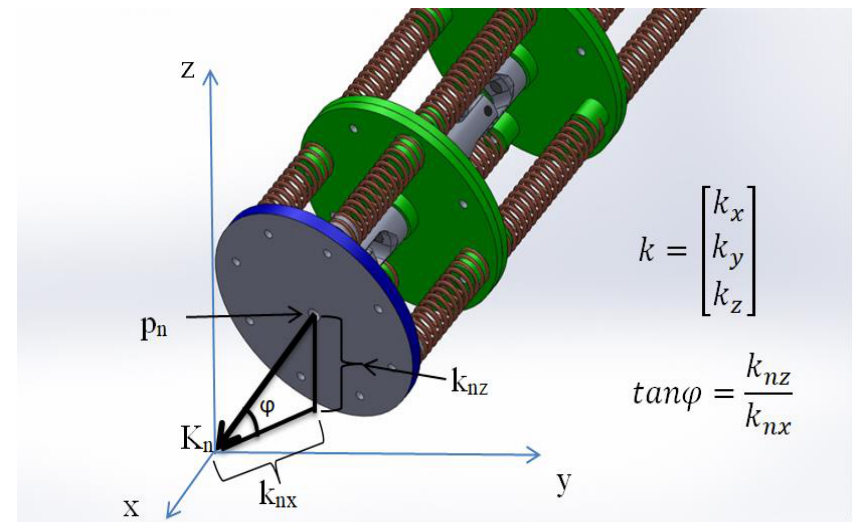
Figure 20. End-effector orientation